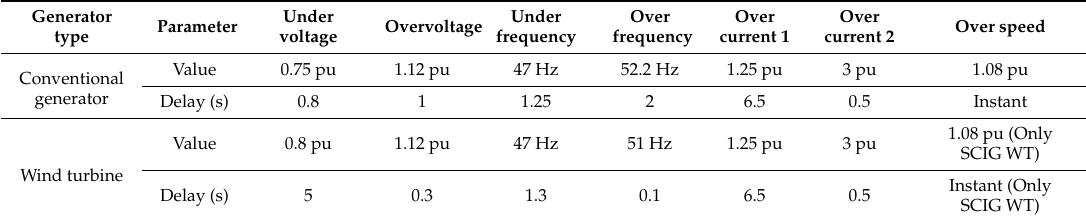
Table 2. Protection relay settings for conventional units and wind turbines.